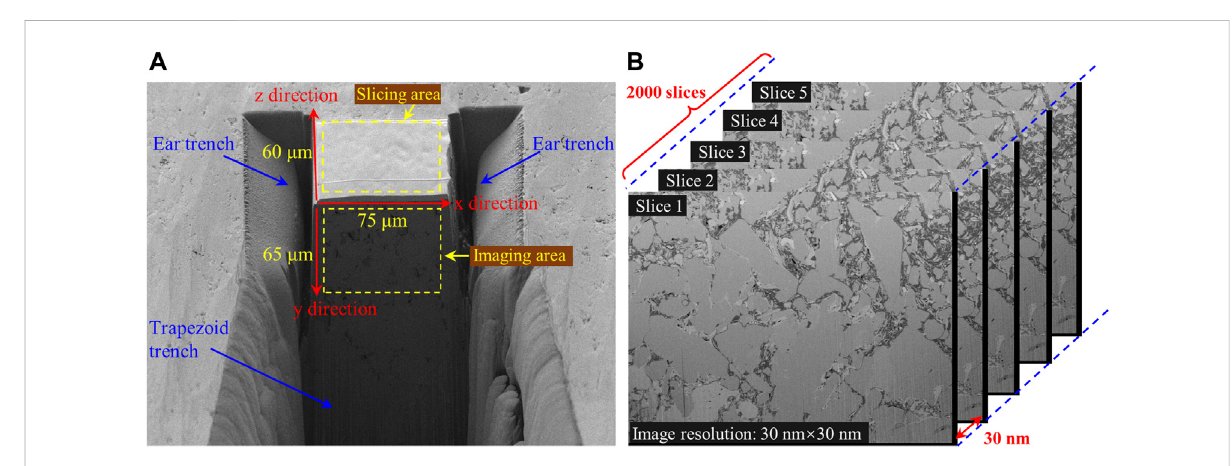
FIGURE 1 Schematic diagram of large-volume 3D reconstruction using FIB-SEM. (A) Pre-treatment of the sample for 3D reconstruction showing the positions of the trapezoidal and ear trenches and the imaging area; and (B) stacked SEM slices illustrating the consecutive slicing process.